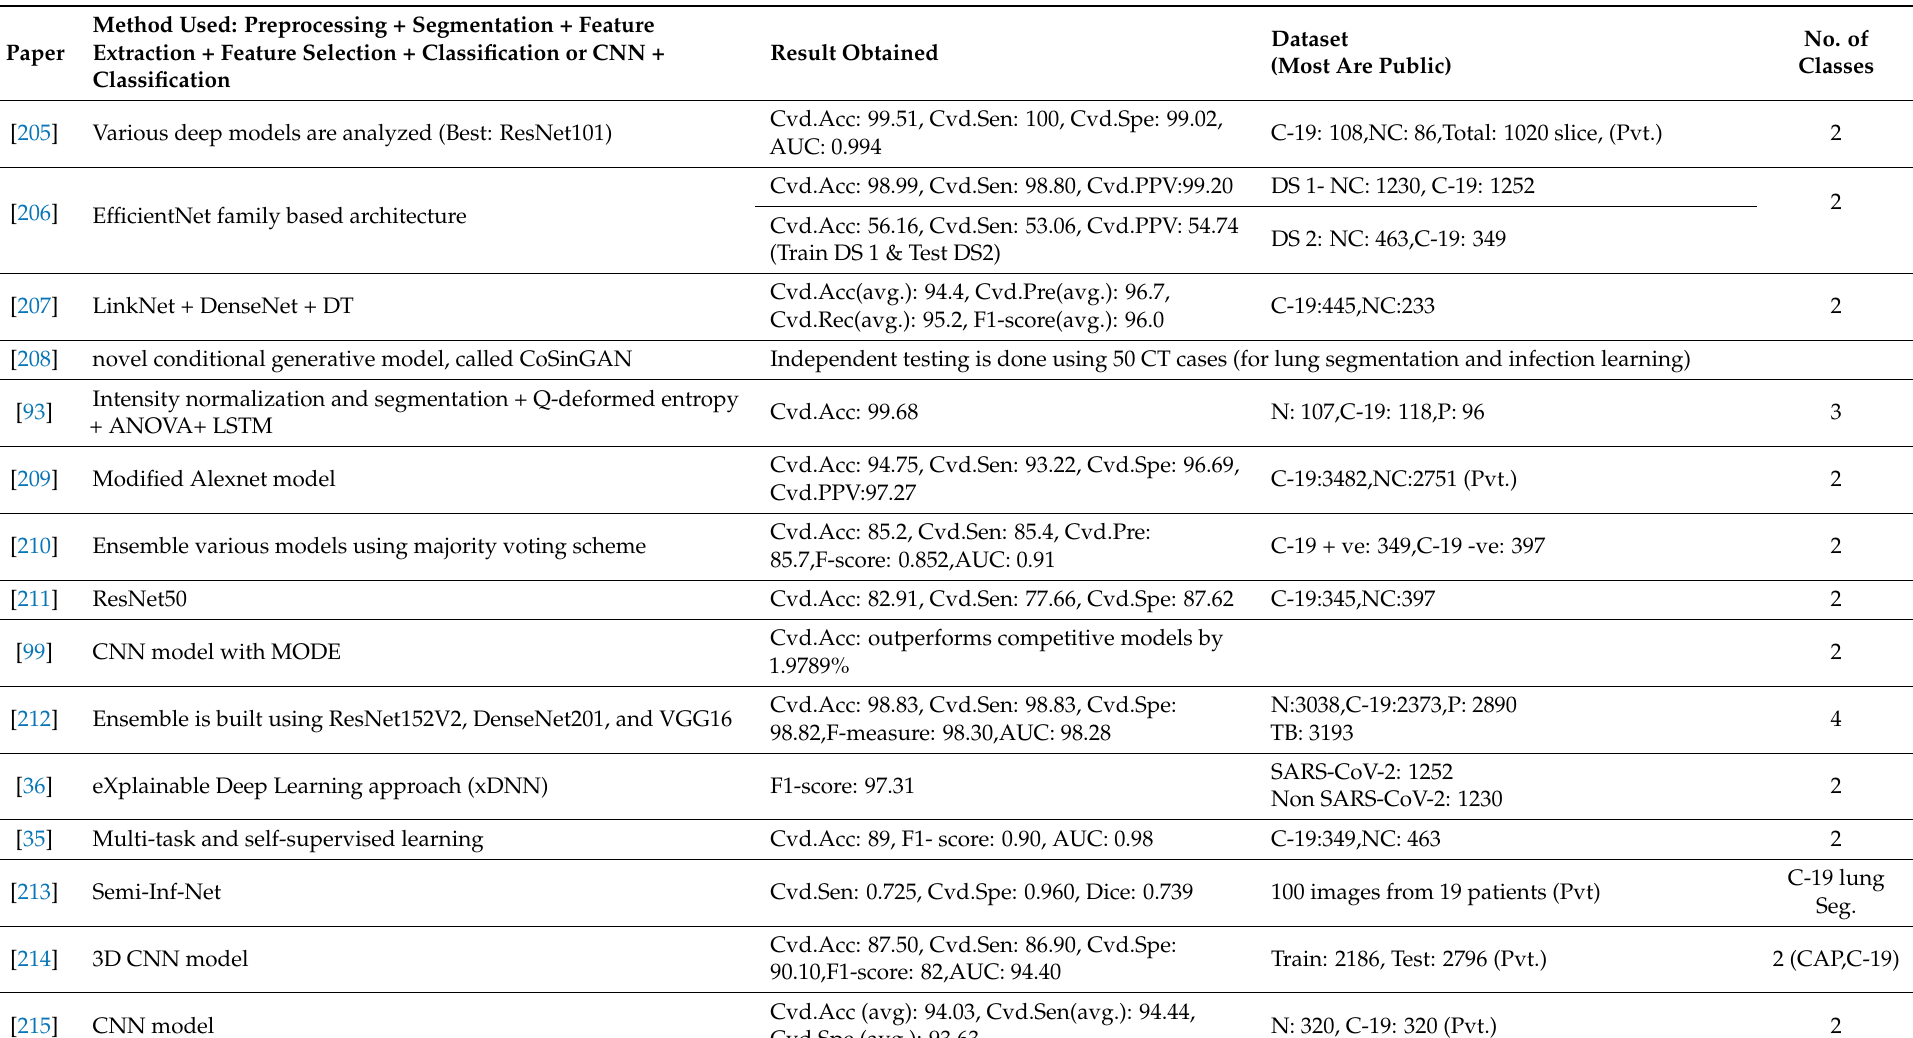
Table 3. State-of-the-art AI techniques to detect COVID-19 using CT